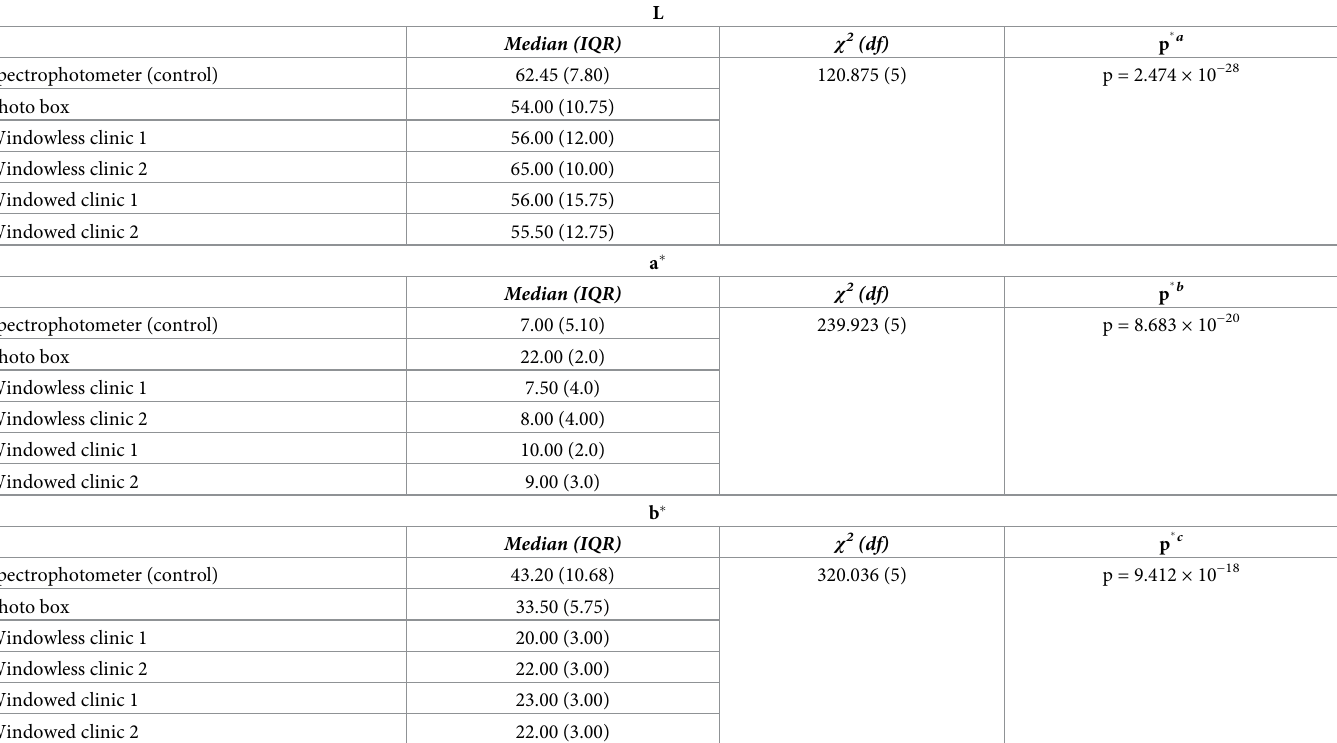
• b � values obtained from 1) photo box vs . windowless clinic 1 (t-stat = -1.029, p = 0.303); 2) windowless clinic 1 vs . windowless clinic 2 (t-stat = -1.355, p = 0.175); and 3) windowed clinic 1 vs . windowed clinic 2 (t-stat = 1.304, p = 0.192)